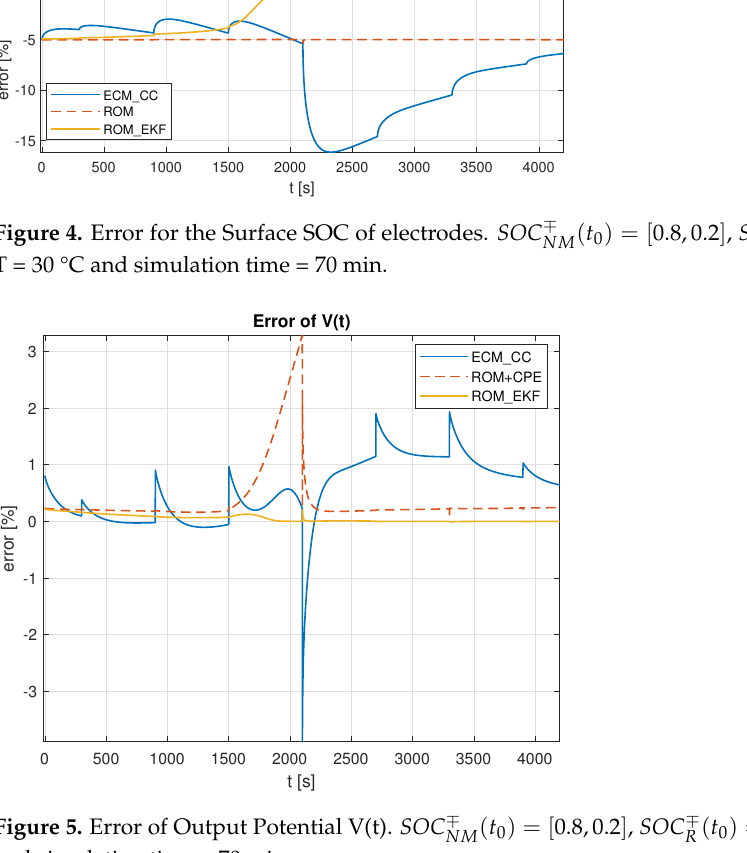
Figure 5. Error of Output Potential V(t). SOC ∓ and simulation time = 70 min.